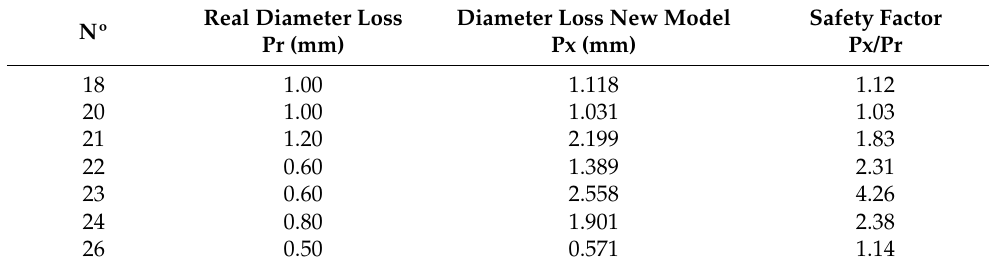
Table 9. Case studies with favourable results using the New Empirical model (2019).